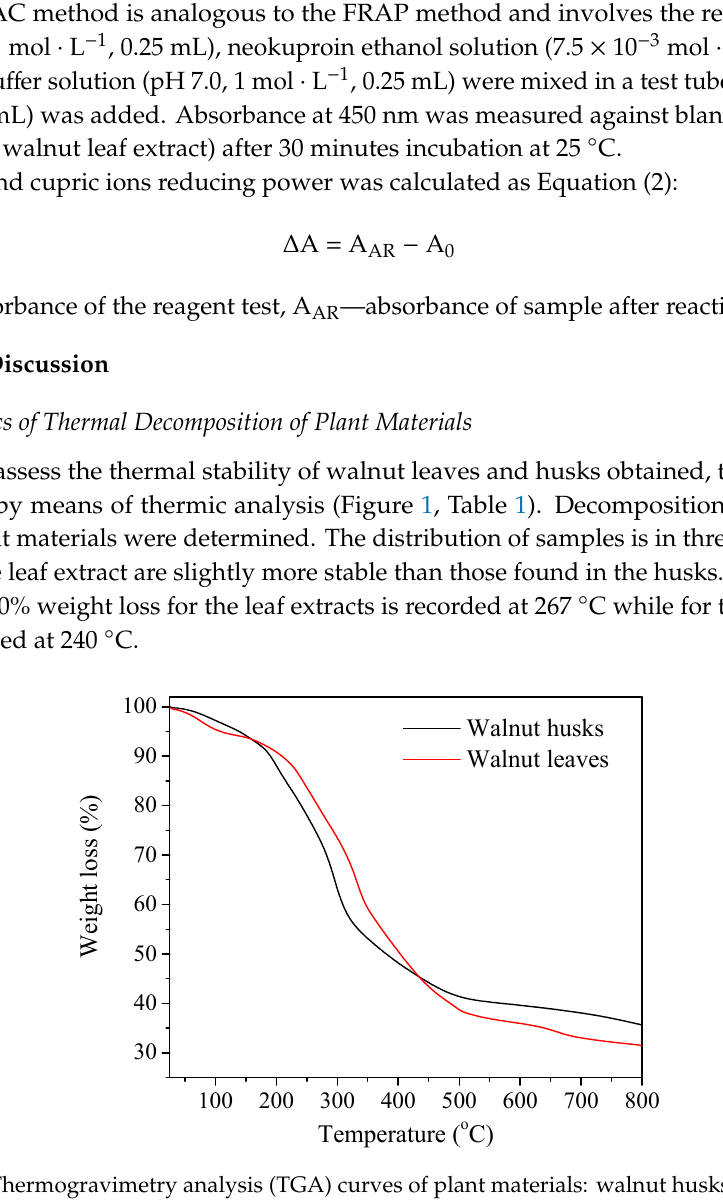
Figure 1. Thermogravimetry analysis (TGA) curves of plant materials: walnut husks and leaves. Table 1. T 20 , T 50 , and T 65 of plant materials: walnut husks and leaves. Sample